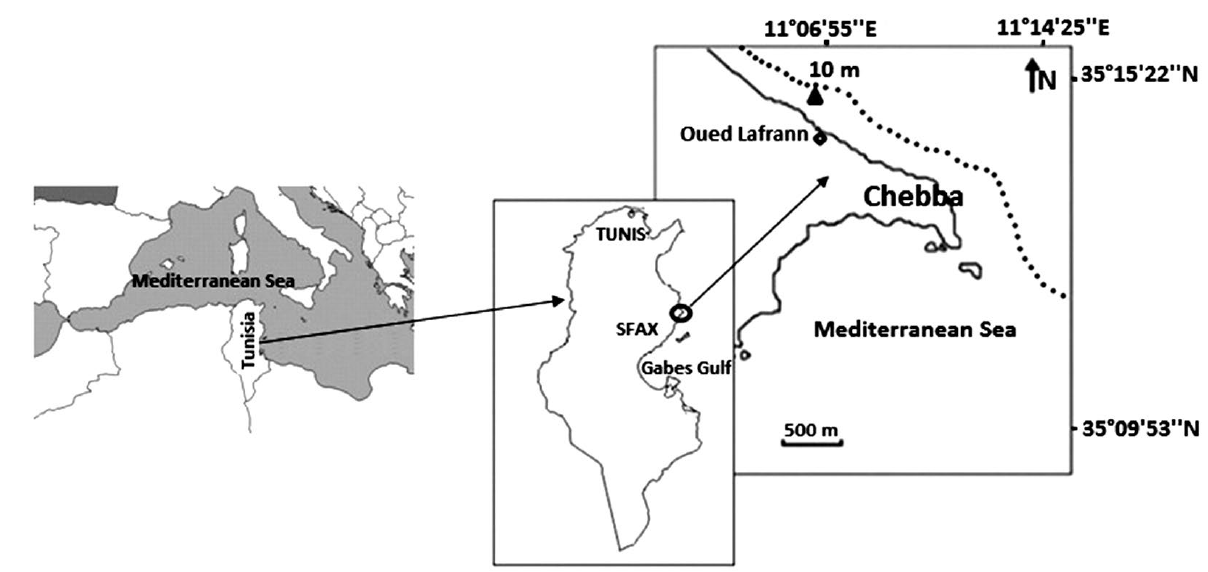
Fig. 1. – Map of the study area, showing the sampling